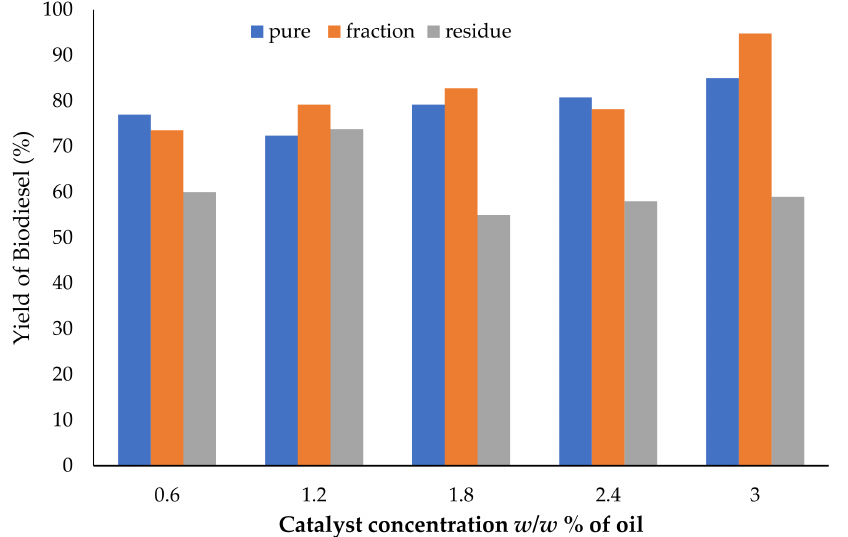
Figure 5. Effect of catalyst concentration on the biodiesel yield produced from interesterified pure oil, fraction and